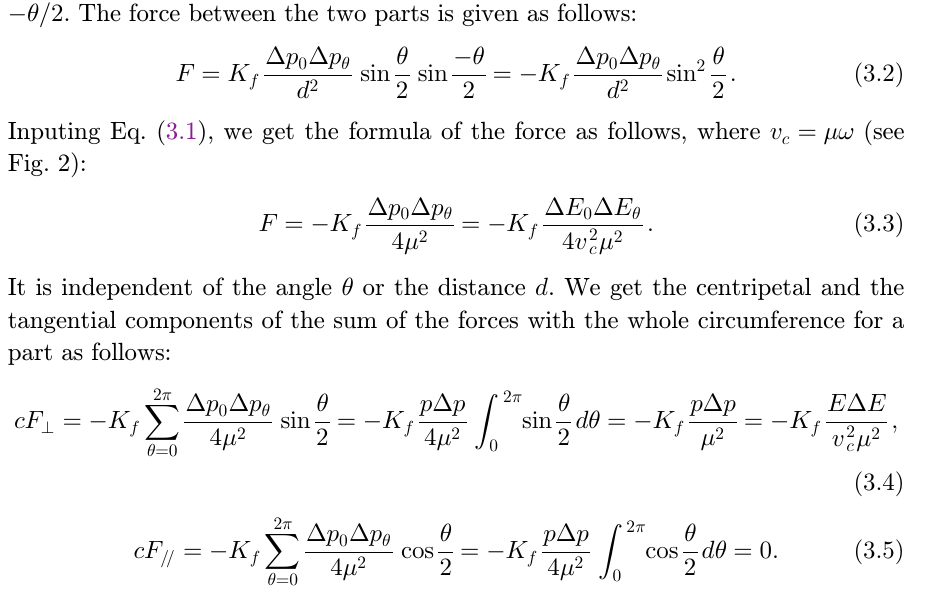
The respective angles of the local momentums to the distance direction are (cid:2)= 2 and